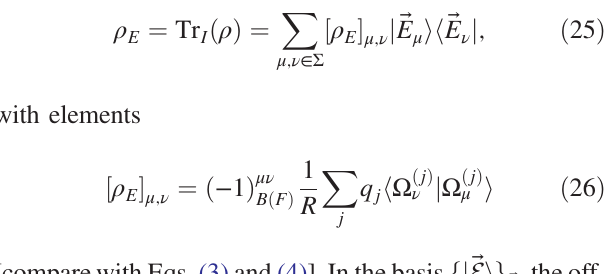
⃗ R ¼ ð 2 ; 1 ; 0 ; … ; 0 Þ and, ⃗ E ¼ ð 1 ; 1 ; 2 Þ . External I